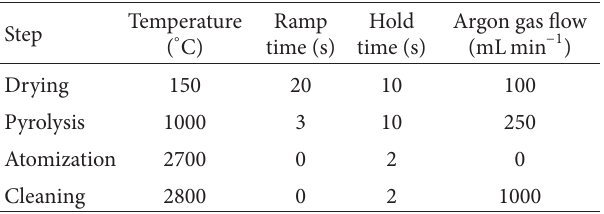
T 1: Graphite furnace temperature for determination of palla-